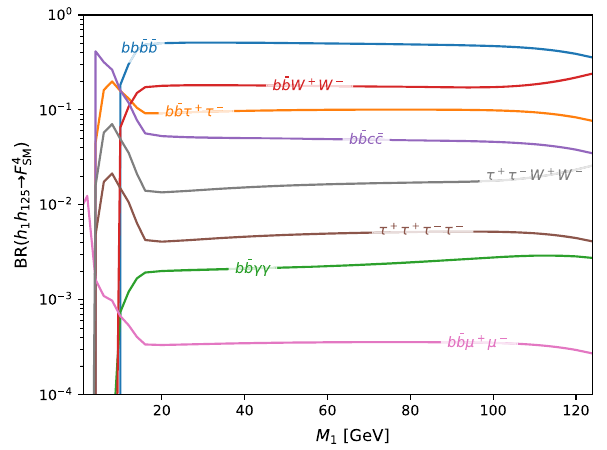
Fig. 8 Branching ratios of the h 1 h 125 state decaying into selected SM final states as a function of M 1 for BP2